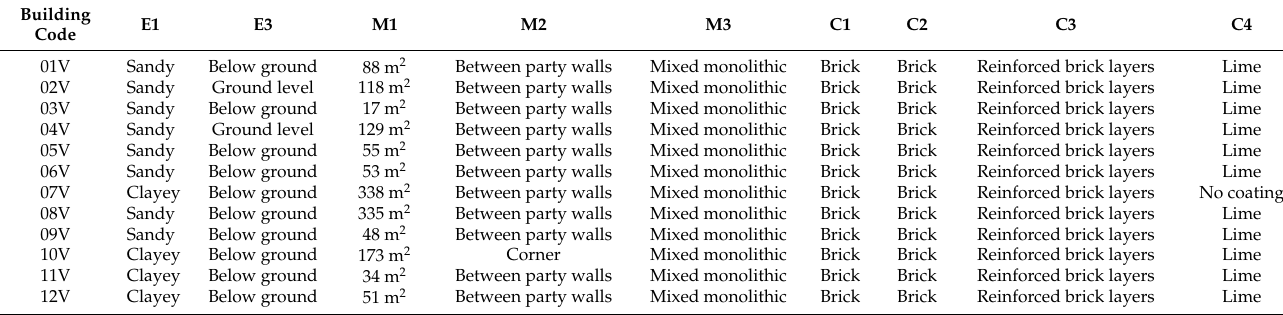
Table 5. Vernacular building